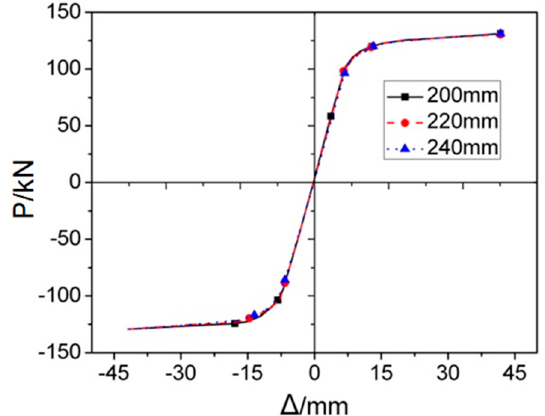
Figure 25. The skeleton curves of RD series FE models under cyclic loading.